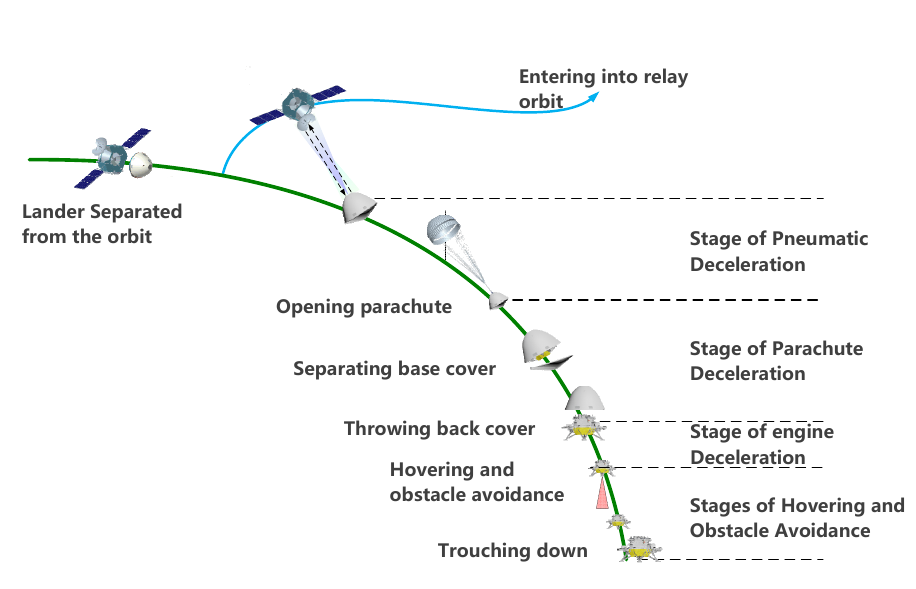
Figure 1. Diagram of the entry, descent and landing of Tianwen-1.